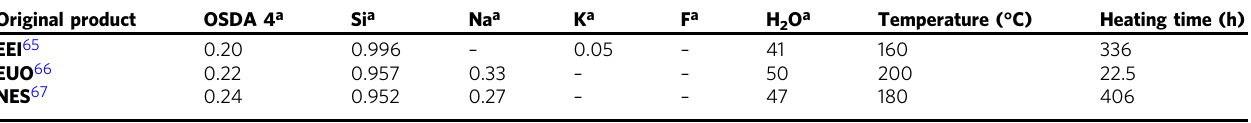
Table 1 Explored synthesis conditions for crossover experiments Original